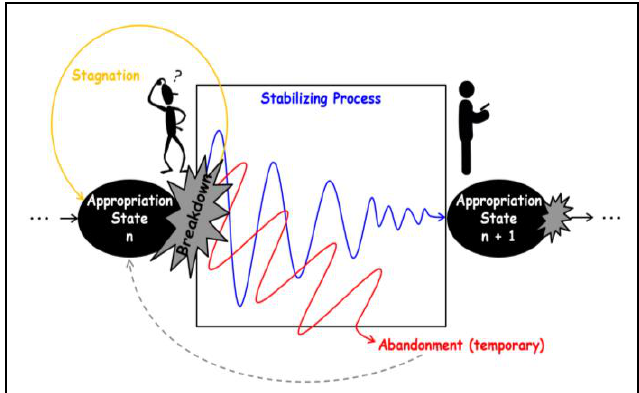
Fig. 1. Appropriation as states and possible events or processes in-between